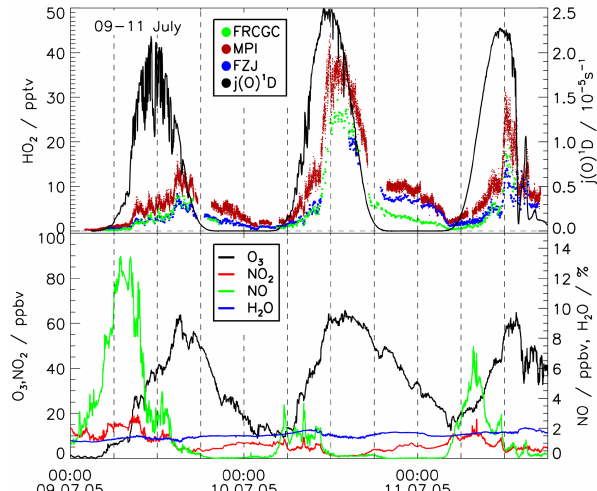
Fig. 2. Time series of HO 2 mixing ratios during ambient air sam- pling from all instruments at their original time resolution together with the photolysis rate j( O 1 D ) (black line upper panels). In ad- dition, mixing ratios of O 3 (UV absorption photometer), NO 2 and NO (chemiluminescence detector), and water vapor (dewpoint hy- grometer) are shown in the lower